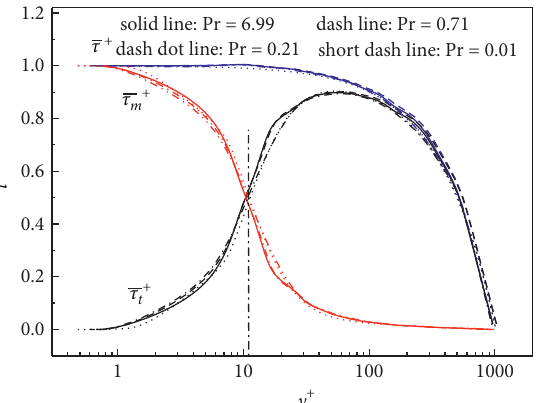
+ � u ′ v ′ ), and total shear stress ( τ + � τ + m + τ + t ) of t